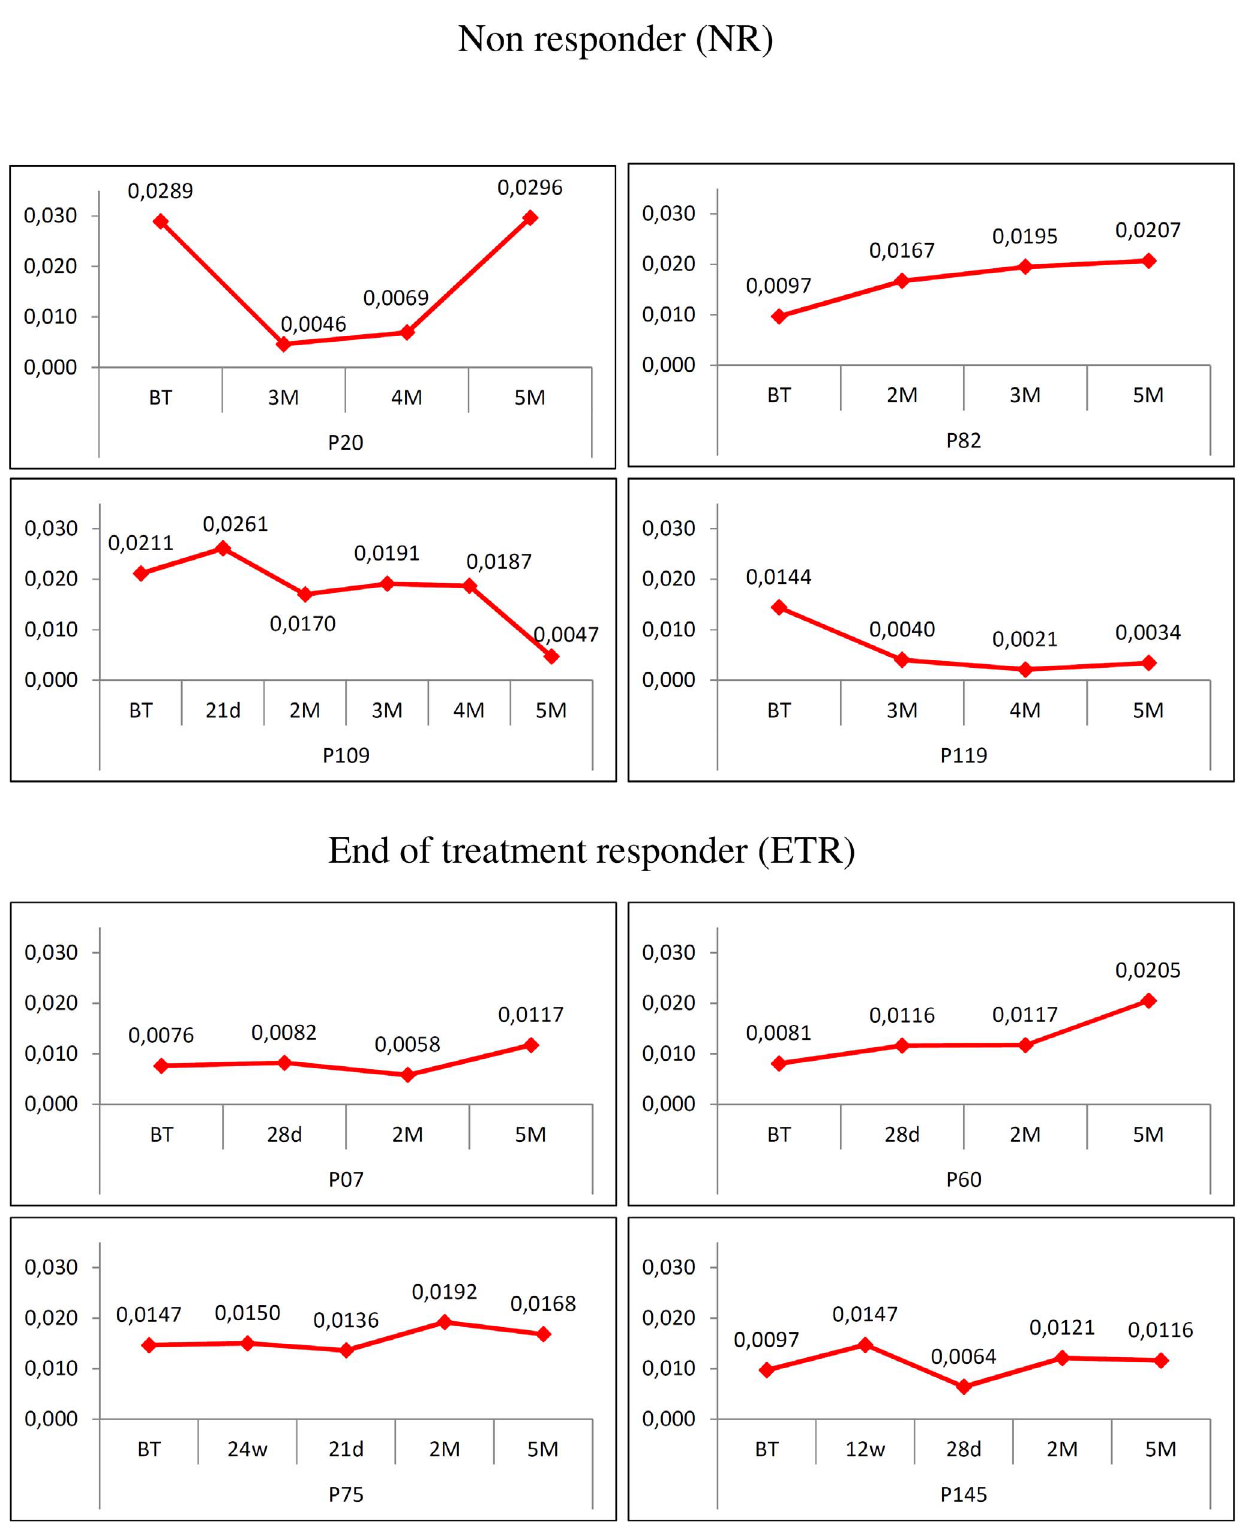
Figure 2. Genetic distance. Genetic distances calculated by the number of base differences per site from between sequences within each time point for each patient. BT-Before treatment; w-weeks; d-days; M-months.